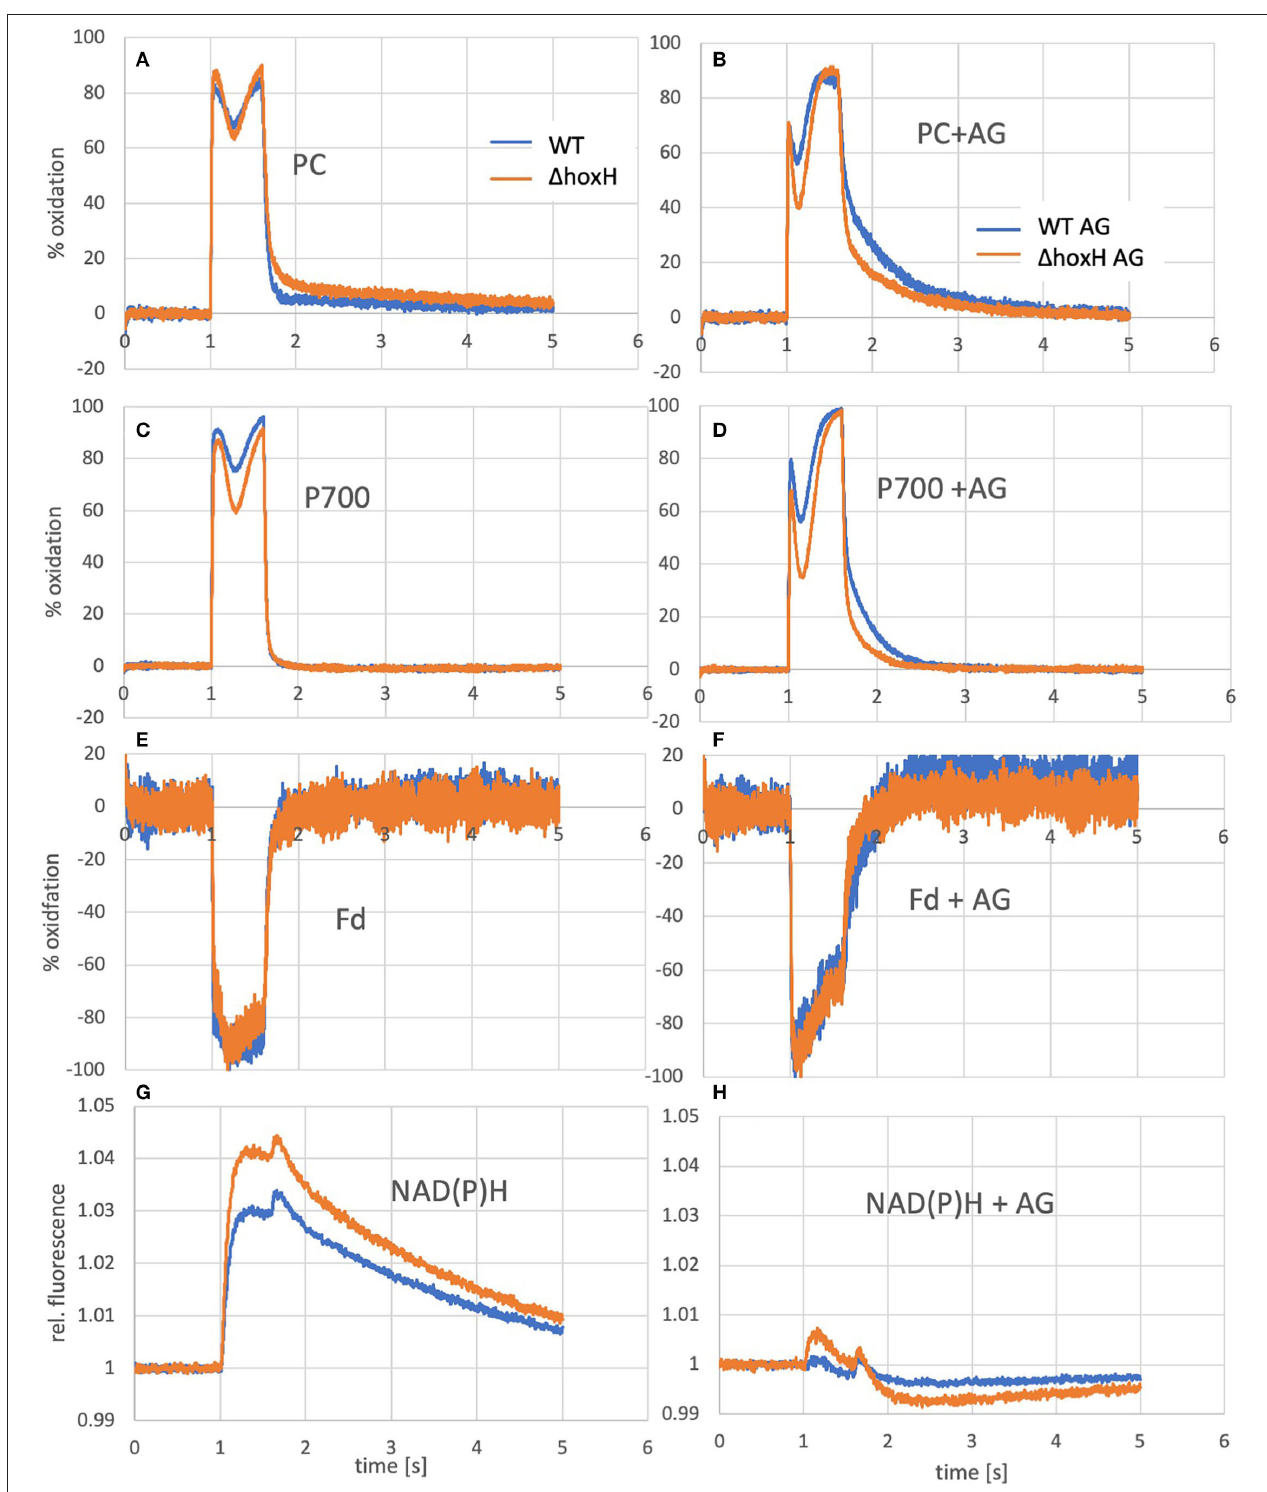
FIGURE 6 | Oxidation of PC and P700 and reduction of ferredoxin and NADPH of WT and 1 hoxH cultures as measured by the Dual-KLAS/NIR. On the left (A, C, E, G) , curves of cultures grown photoautotrophically are shown and on the right (B, D, F, H) , the same cultures are shown that were measured a few minutes after the addition of arginine and